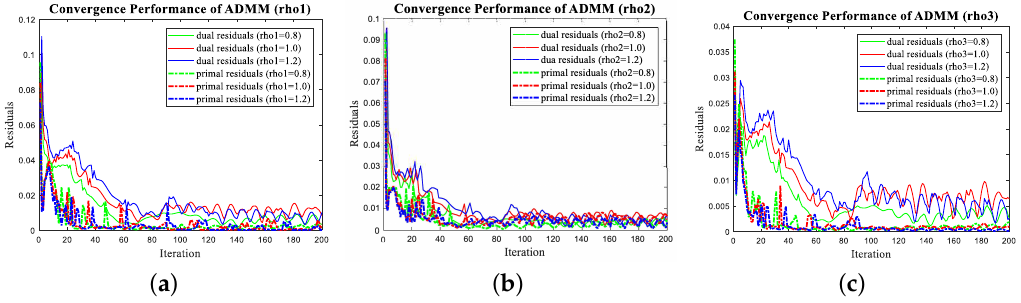
Figure 4. Convergence of primal residuals and dual residuals with different penalty parameters: ( a ) testing on penalty ρ 1 ; ( b ) testing on penalty ρ 2 ; and ( c ) testing on penalty ρ 3 . (2) Effect of λ 3